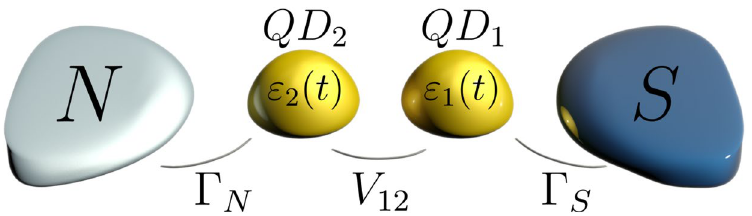
Figure 1. Schematics. Two quantum dots (QD 1 and QD 2 ) coupled in series between the superconducting (S) and normal (N) metallic reservoirs whose energy levels ε i σ ( t ) could be varied by the external gate potential. We also consider dynamical phenomena driven by the time-dependent bias voltage imposed between the external